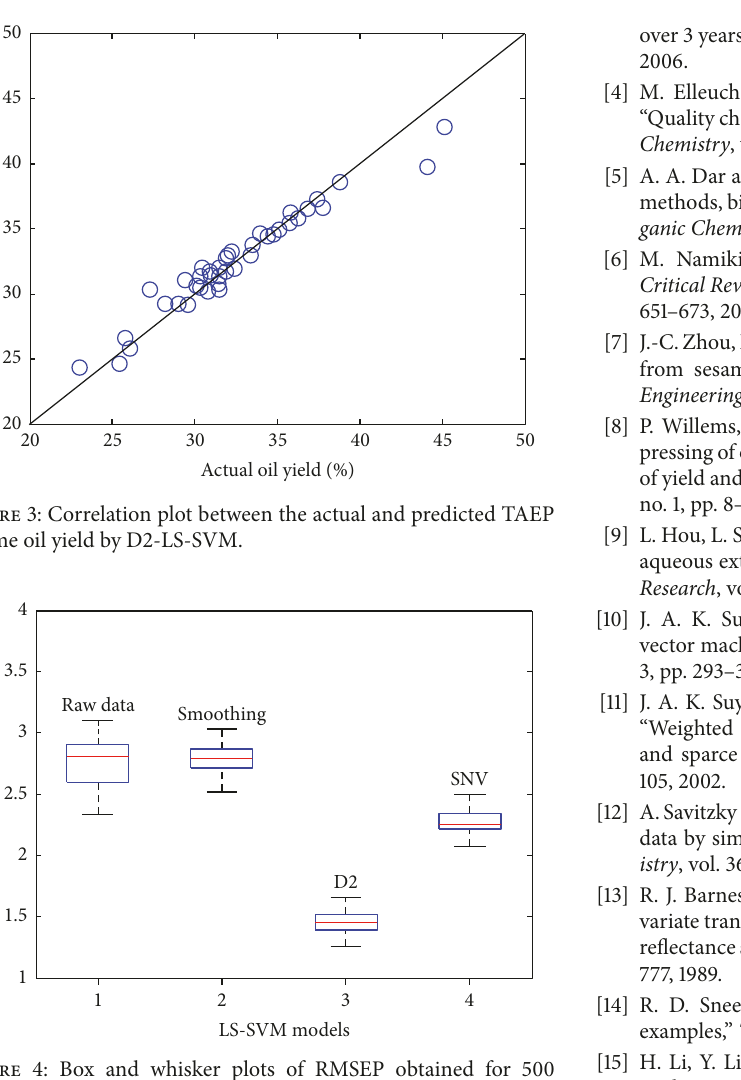
Figure 4: Box and whisker plots of RMSEP obtained for 500 repeatedparameteroptimizationsforLS-SVMmodelswithdifferent data preprocessing methods. Each plot indicates the minimum, lower quartile, median, upper quartile, minimum, and maximum of